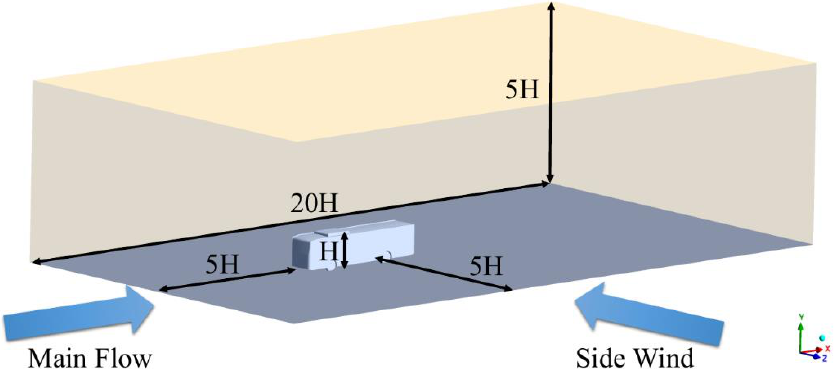
Figure 2. Sideview of the bus.